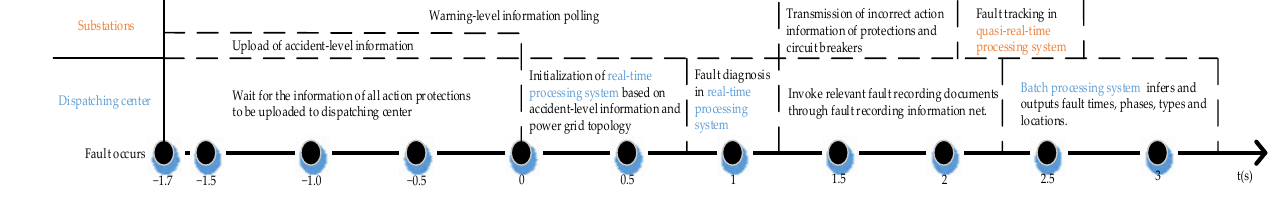
Figure 12. System time-consuming test.